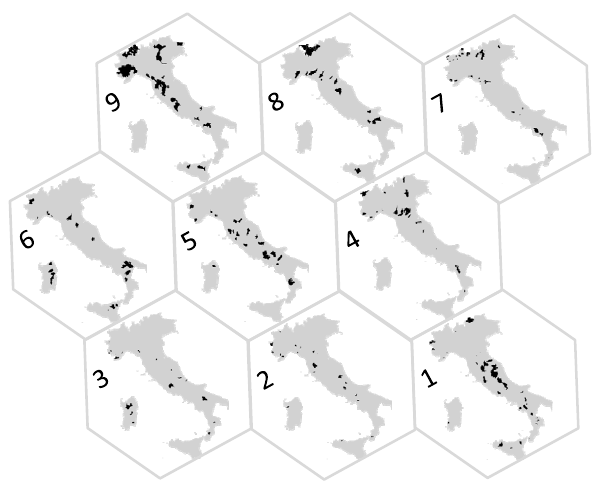
Fig. 6. Reference classification SOMY.